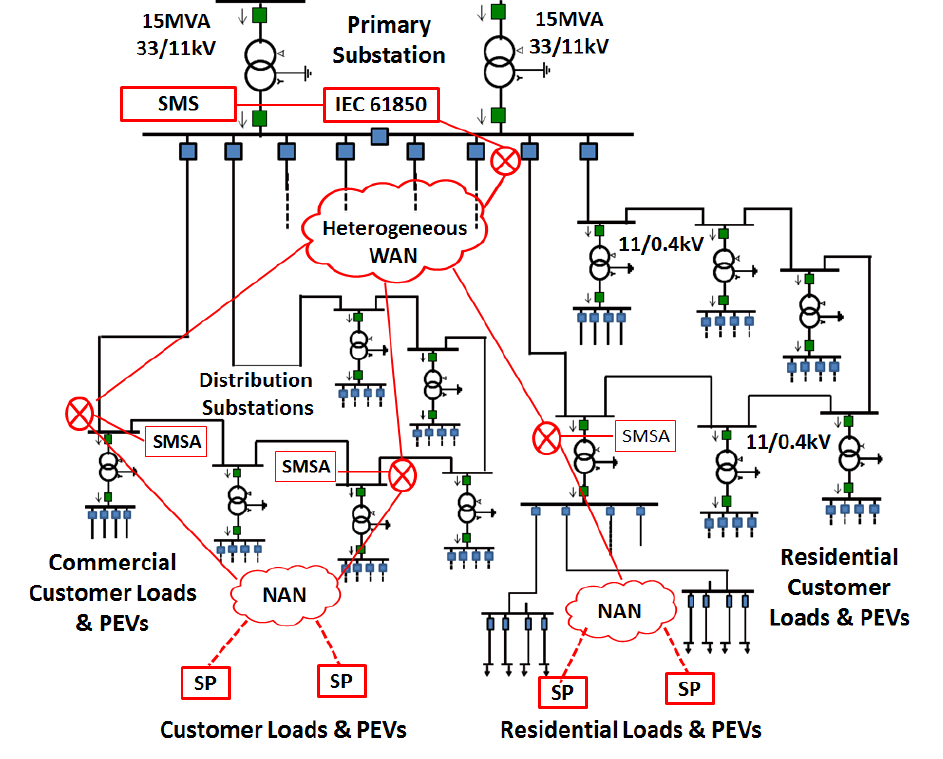
Figure 1. Urban electric distribution system and PEVs in customer